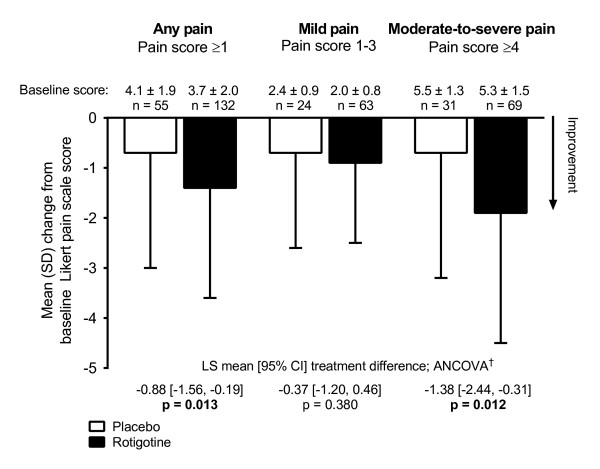
Likert pain scale change from baseline in patients with pain at baseline.†ANCOVA model with treatment and region as factors and baseline pain score as the covariate. ANCOVA: analysis of covariance; CI: confidence interval; LS: least square; SD: standard deviation.